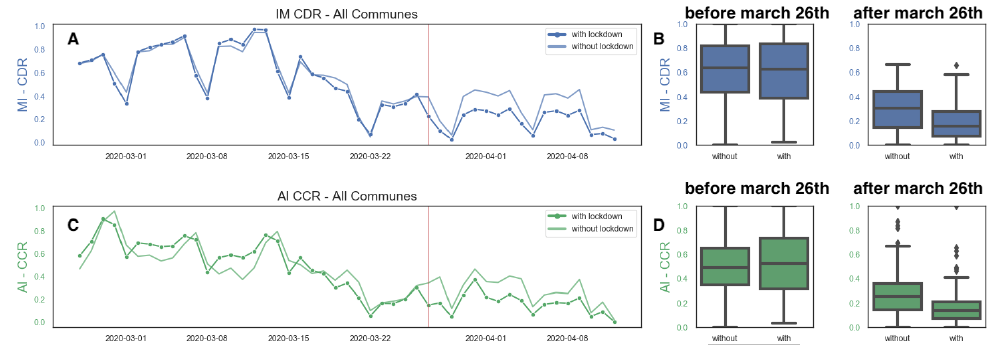
Figure 10. The effect of lockdown policies in Santiago, Chile. Aggregated data from the beginning of March 2020 until April 15th. The red line indicates March 26th. ( A ) CDR activity for communes with and without lockdown. ( B ) Box-plots of CDR activity in communes with and without lockdown before and after March 26th. ( C ) CCR activity for communes with and without lockdown. ( D ) Box plots of CCR activity in communes with and without lockdown before and after March